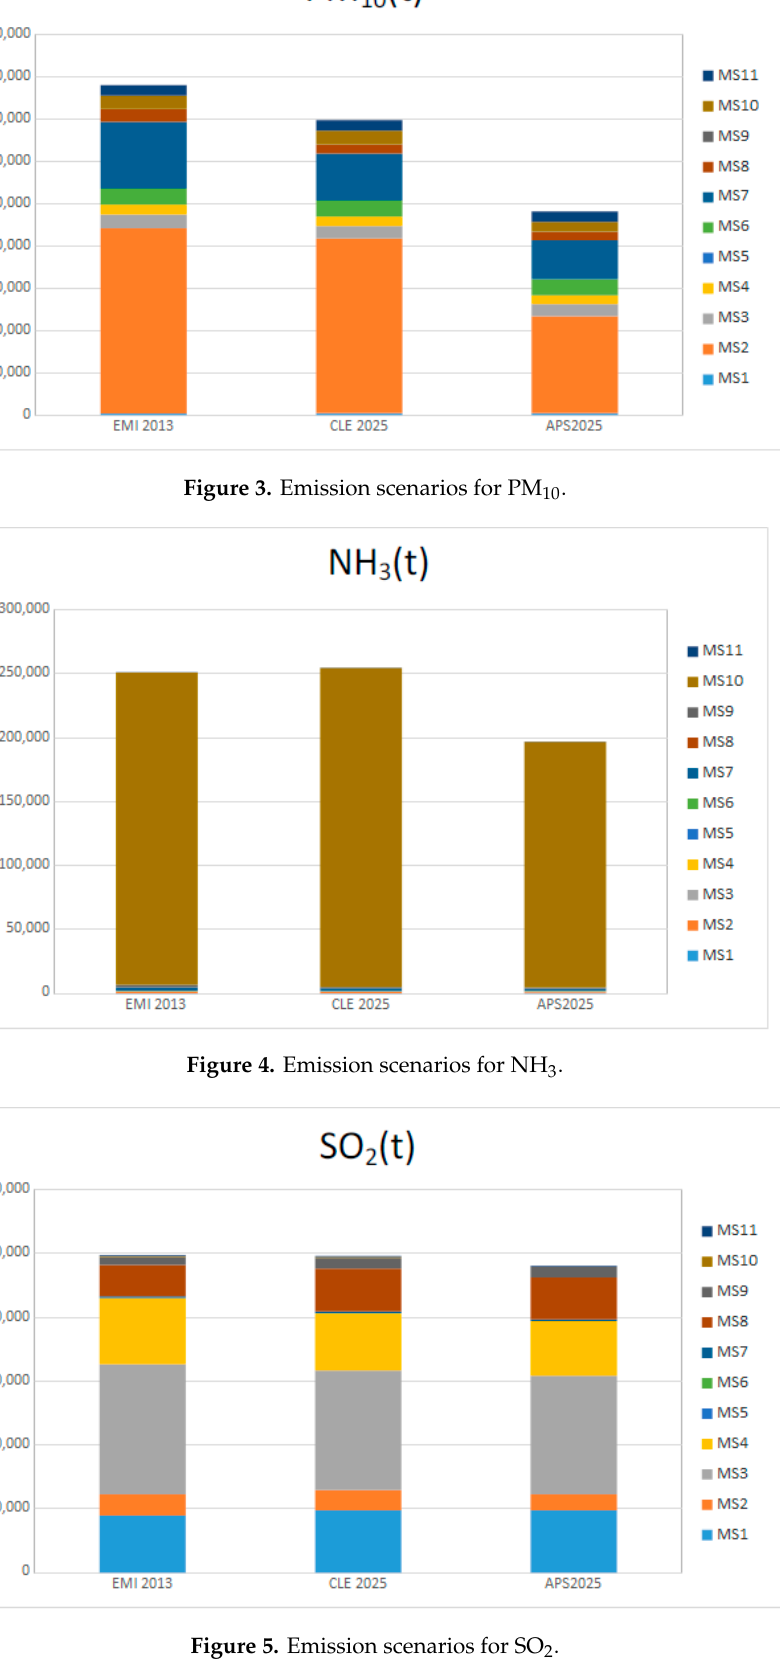
Figure 5. Emission scenarios for SO 2